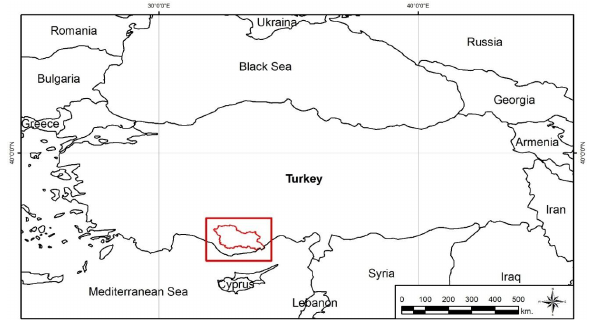
Figure 1. Location of the Goksu